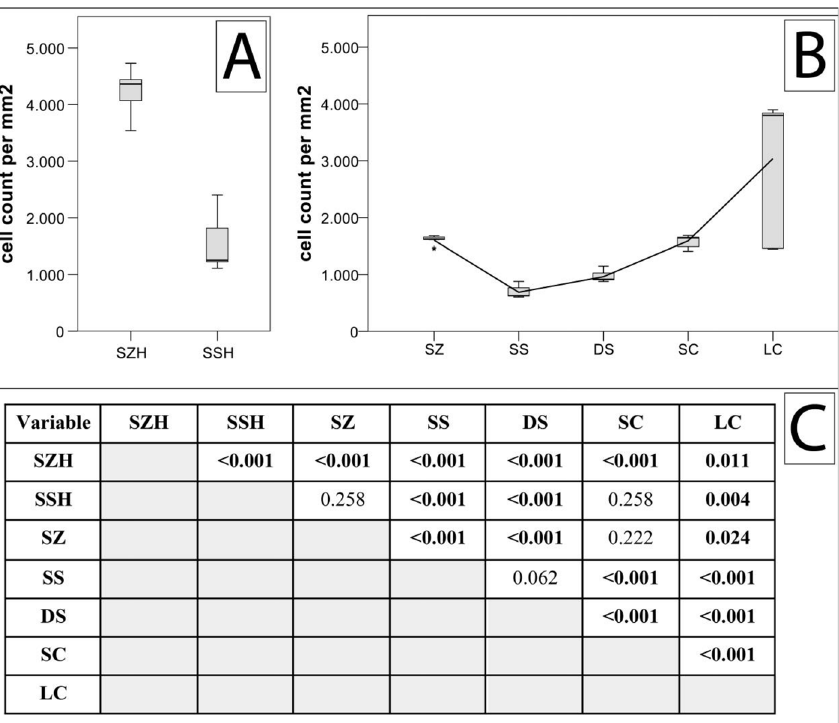
Figure 6. Cellular density in healthy ( A ) and osteoarthritic ( B ) cartilage as a function of cellular organisation. P -values are listed in ( C ) with significant p -values denoted in bold. Significance was determined on an FDR- adjusted alpha (for absolute cell count values, see Table 1; for exact FDR-adjusted alphas, see supplementary Table 1). Abbreviations: SZH—superficial zone healthy cartilage; SSH—single strings healthy cartilage; SZ— superfical zone; SS—single strings; DS—double strings; SC—small clusters; LC—large clusters. Significant differences are listed in the table below. For zonal labelling according to the predominant regional pattern, see also supplementary Figure 5. This figure was created using SPSS Statistics 23 (https:// www. ibm. com/ ch- de/ produ cts/ spss- stati stics), Microsoft Office Word (https:// www. micro soft. com/ de- ch/ micro soft- 365/ word) and Adobe Illustrator CS6 (https:// www. adobe. com/ ch_ de/ produ cts/ illus trator. html).